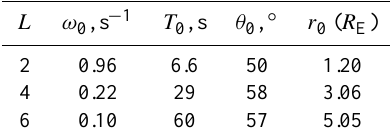
Figure 2. The magnetic field lines of L = 2 , 4 , 6 on the noon– midnight meridional plane for the compressed dipole with B 0 = 0 . 31 Gauss, b 1 = 10nT and b 2 = 8. The dashed lines mark the lo- cations where the eigenfrequencies of the fundamental mode inter- sect the critical frequencies, i.e., ω 0 = ω c as shown in Fig. 3 and given in Tables 2 and 3. The field-line-aligned orthogonal coordi- nate (n,s,φ) is also shown. Table 2. List of parameters for L = 2 , 4 , 6 of a compressed-dipole field for φ = 0 (noon).